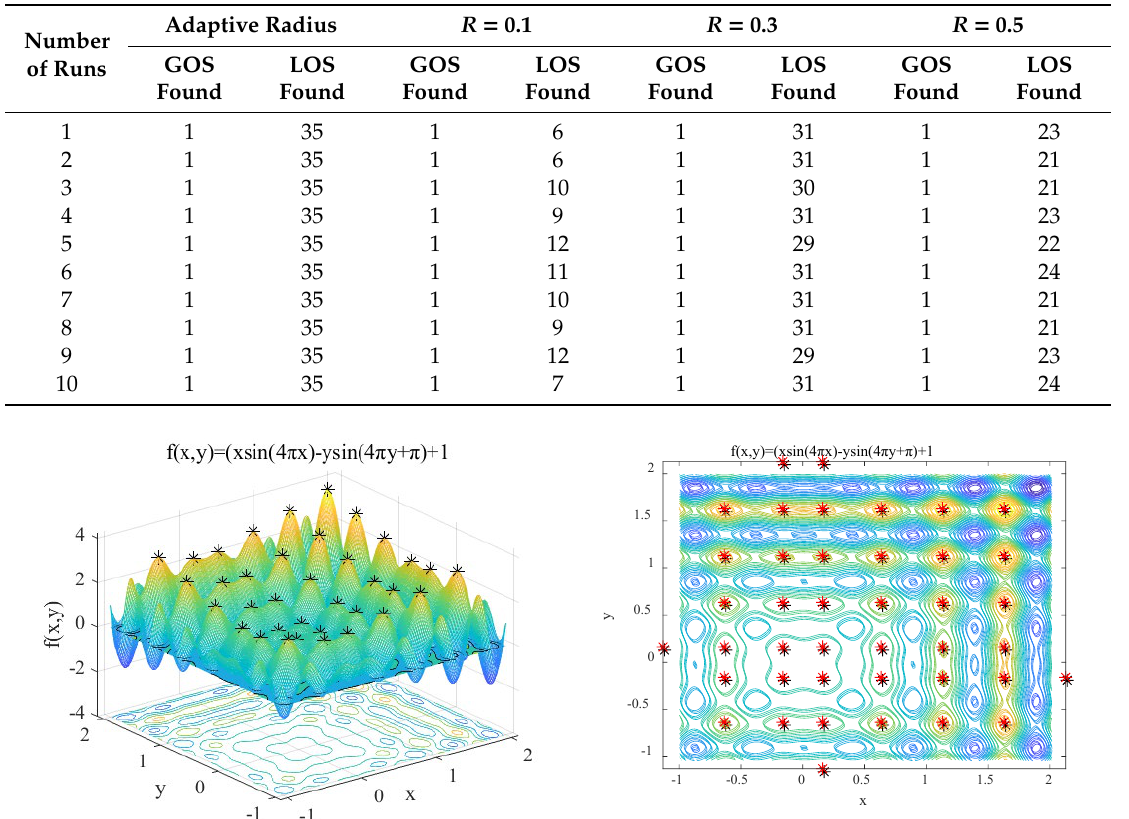
Figure 8. Results of performing IAFSA once to find the peaks of f 2 .